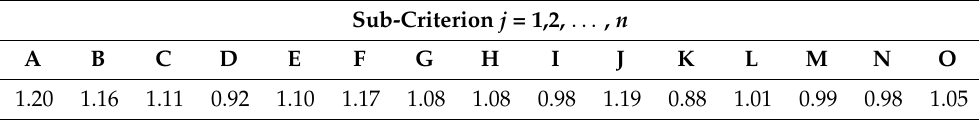
Table 3. The absolute error ∆ j in determining the averages of the 15 sub-criteria ranks R j of the group of 52 surveyed